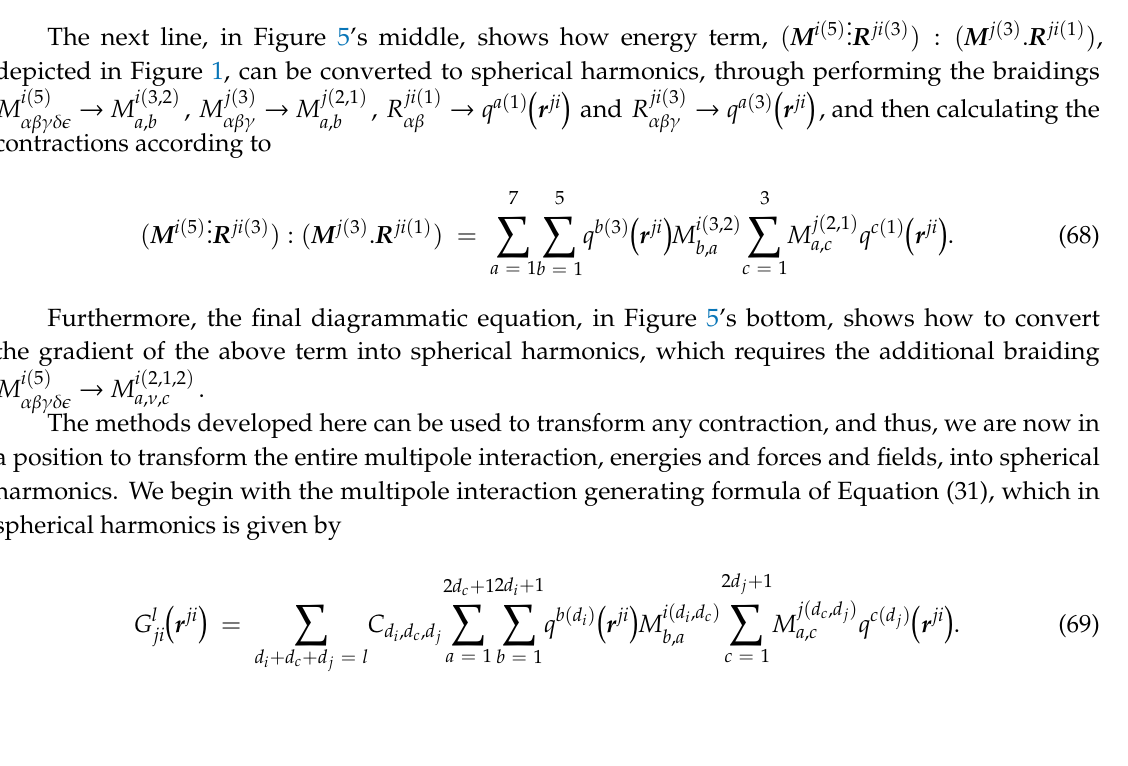
Figure 5. Equivalence of Cartesian and spherical harmonic representations. Top line: Four equivalent ways of representing a rank-4 symmetric traceless tensor. Middle line: two equivalent ways of representing the ( M i ( 5 ) . R ji ( 3 ) ) : ( M j ( 3 ) . R ji ( 1 ) ) tensor product from Figure 1. Bottom: two equivalent ways of representing the gradient of this tensor product. The unbraided spokes represent Cartesian vectors, and the braided spokes are spherical harmonics.